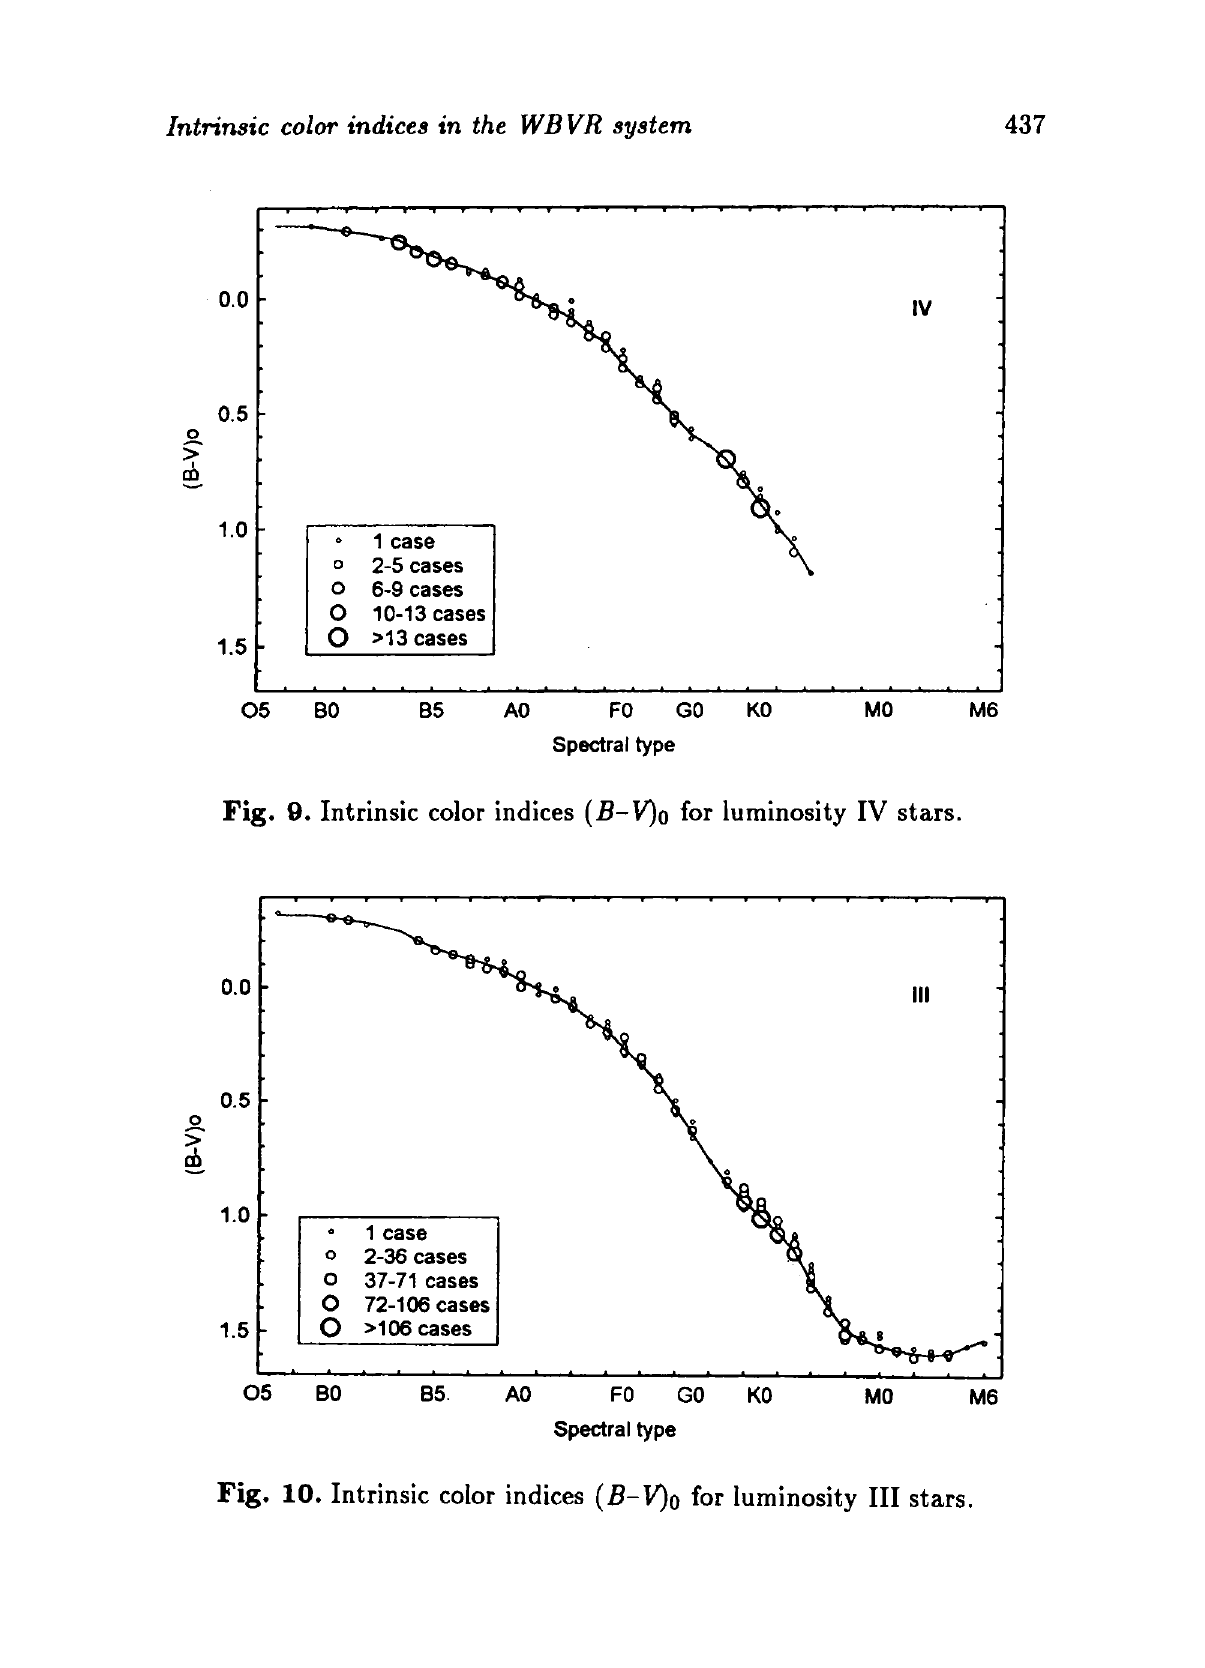
Fig. 10. Intrinsic color indices (B-V) o for luminosity III